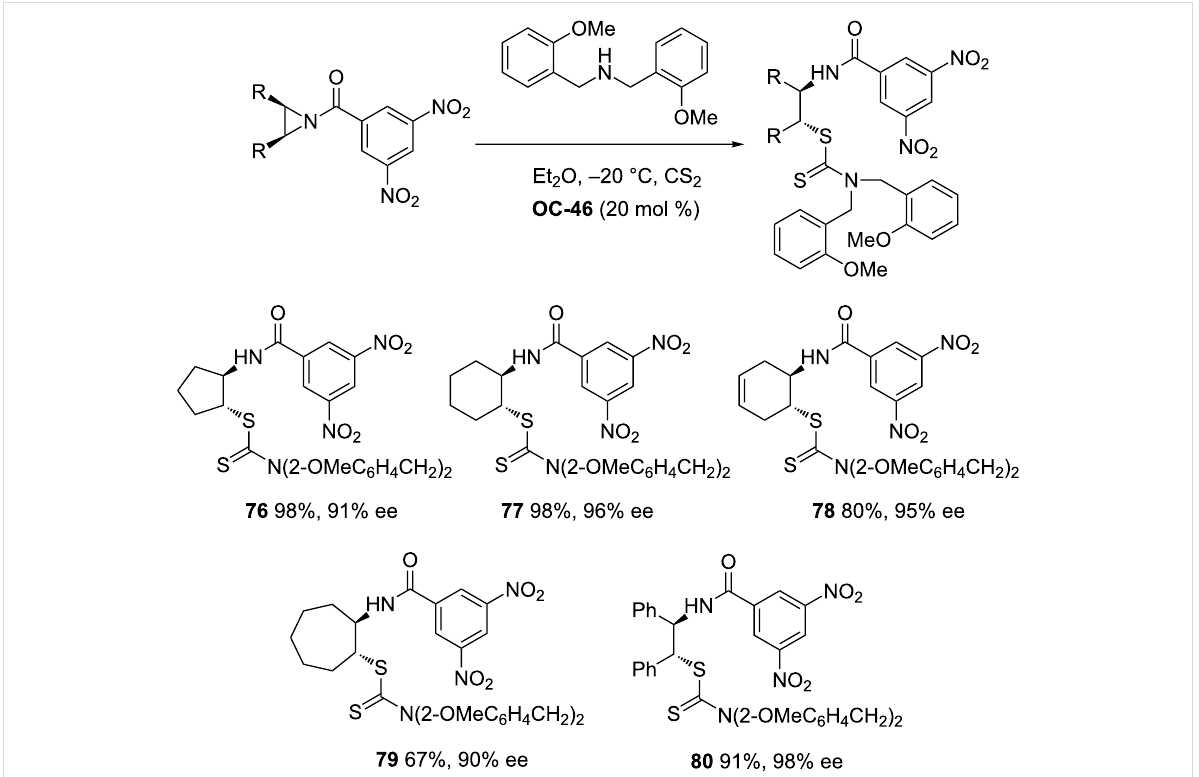
with trimethylsilyl halides by using novel chiral 1,2,3-tri- azolium chlorides ( OC-49 to OC-55 ) as catalysts (Figure 11). The treatment of meso -aziridine with 1 equiv of chiral 1,2,3-tri- azolium chloride OC-49 ·Cl or Me 3 SiCl in toluene at − 40 °C for 12 h did not result in a product formation, but the combined use of a catalytic amount of OC-49 ·Cl (5 mol %) and a stoichio- metric quantity of Me 3 SiCl led to the desired ring-opening product in low yield (35%) and moderate enantioselectivity